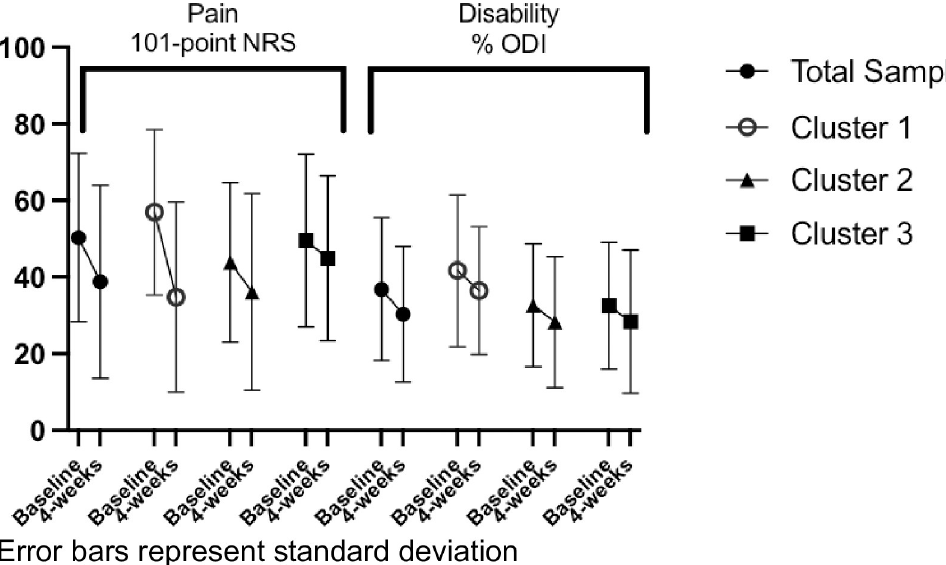
Fig 3. Changes in pain and disability ratings at baseline and 4-weeks for the total sample and by phenotype. Error bars represent standard deviation.